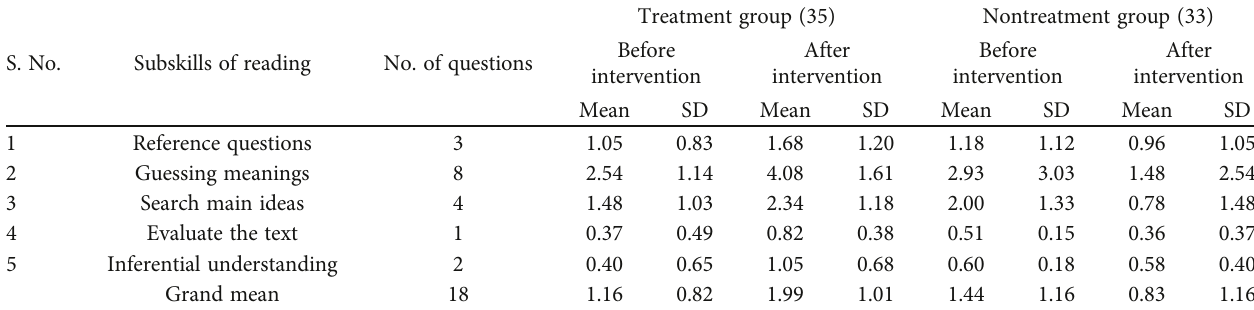
T ABLE 7: Comparison of the mean scores of the nontreatment and treatment groups on questions that offer a higher level of thinking.